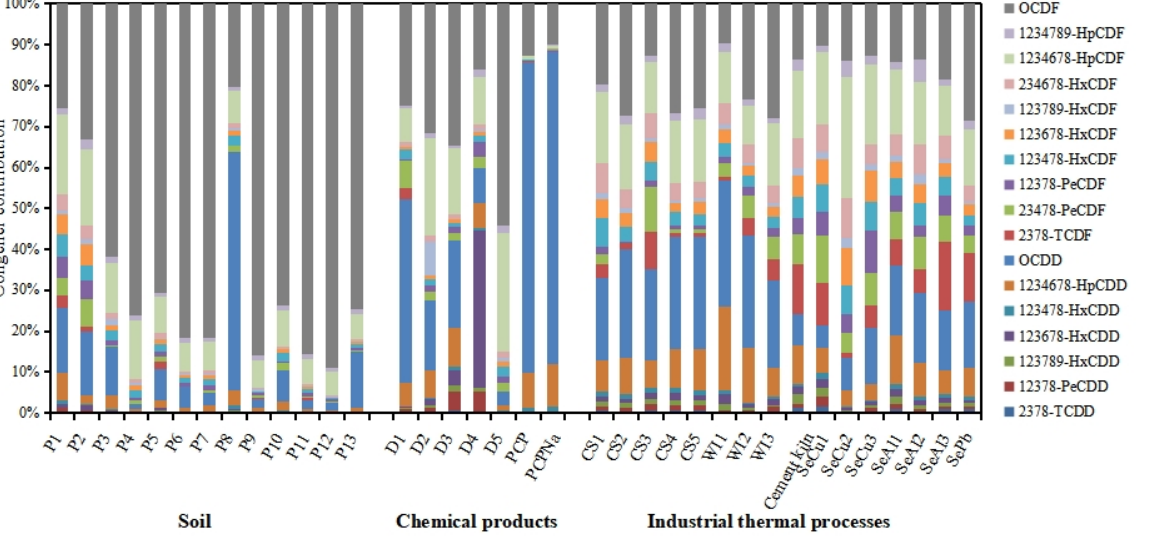
Figure 4. PCDD/F congener patterns in soil samples, 2,4-D butyl esters (D1–5) [5], a pentachlorophenol (PCP), a sodium pentachlorophenate (PCPNa) [4], and stack gas of converter steel plants (CS1–5) [51], cement kiln, secondary coper smelters (SeCu1–3), secondary aluminum smelters (SeAl1–3), secondary lead smelter (SePb) and waste incinerators (WI1–3) [52,55].